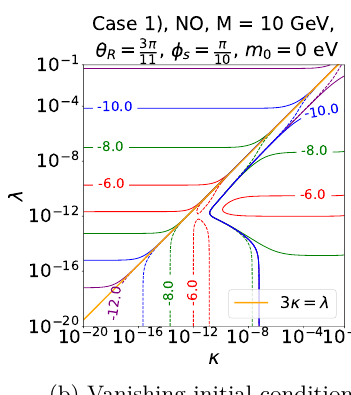
is s 8 . 6 · 10 − 11 . The grey B ≈